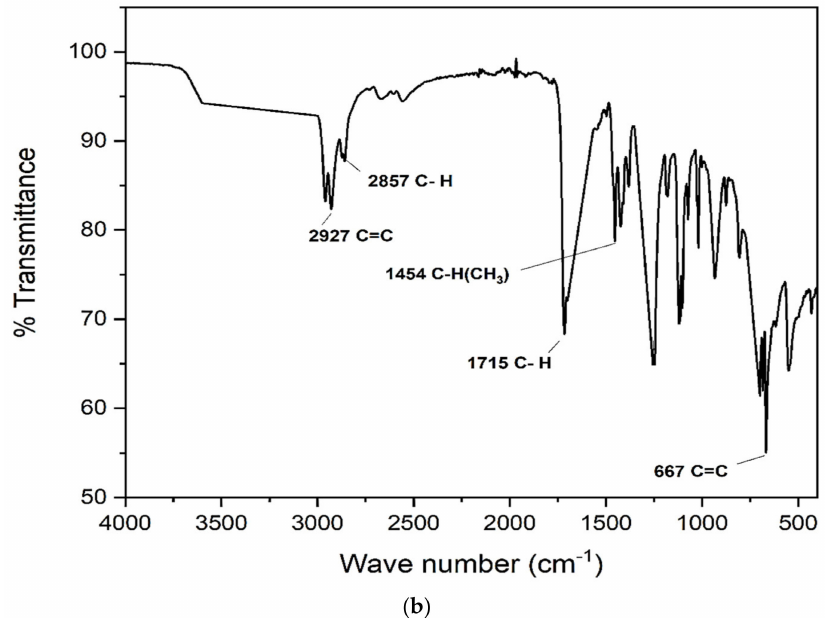
Figure 14. ( a ) FTIR Spectra of Dye Basic Orange 2 before Degradation. ( b ) FTIR Spectra of Basic Orange 2 Dye after Degradation by Escherichia coli .